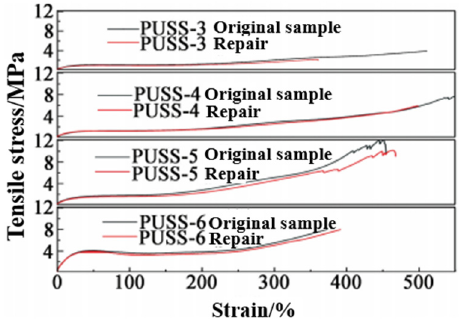
Figure 10. Tensile stress-strain curves of samples with different disulfide contents.